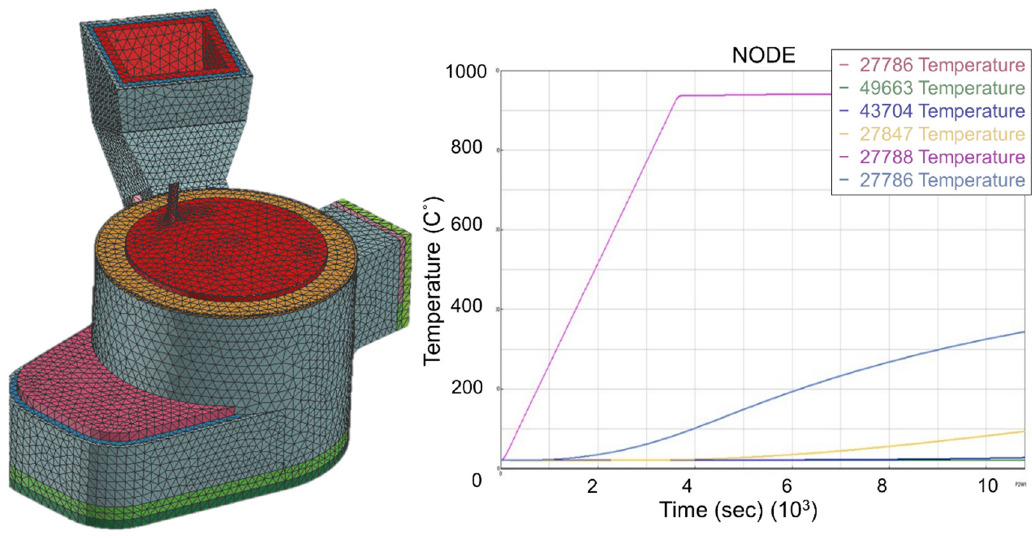
Figure 8. Meshing for analysing the temperature profiles and temperature time curve of the furnace.